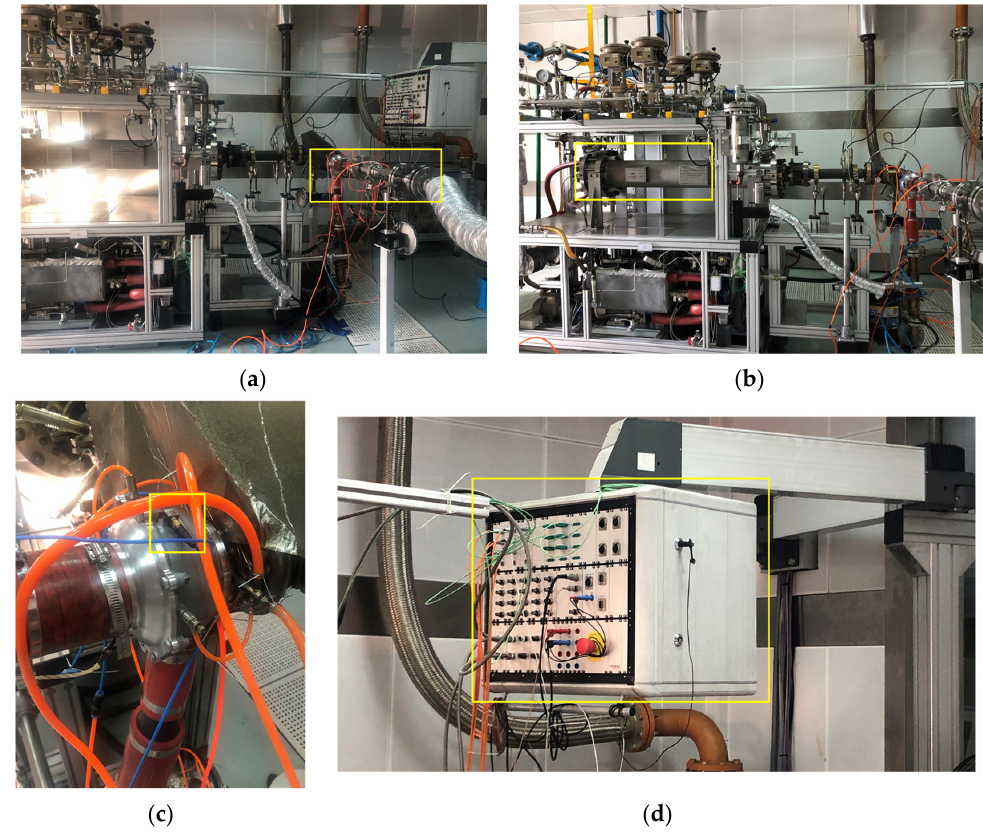
Figure 4. The schematic layout of the coaxial-rotor unit.